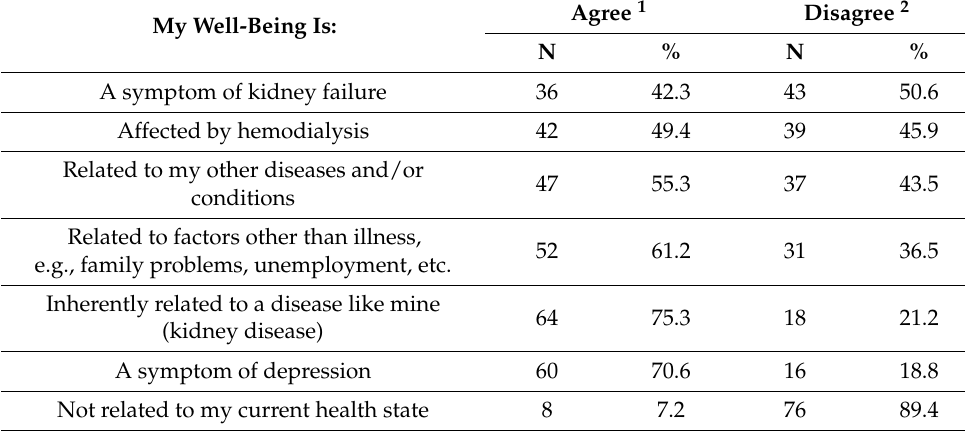
Table 2. Well-being of patients with untreated depression according to the List of Explanations of Well-Being (LEWB), aggregated responses (detailed data in File